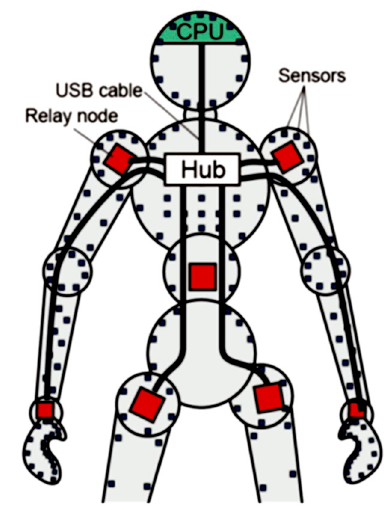
Figure 1. Image of nerve-net tactile sensing in robot.